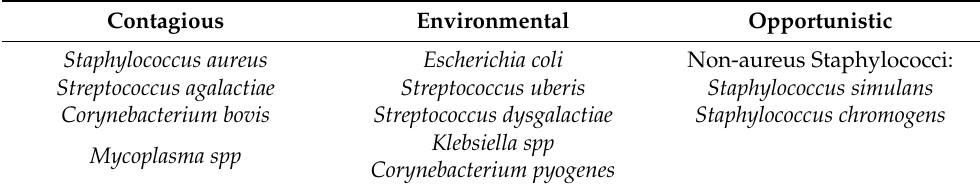
Table 1. Classification of mastitis pathogens Adapted from Constable and colleagues (2017)